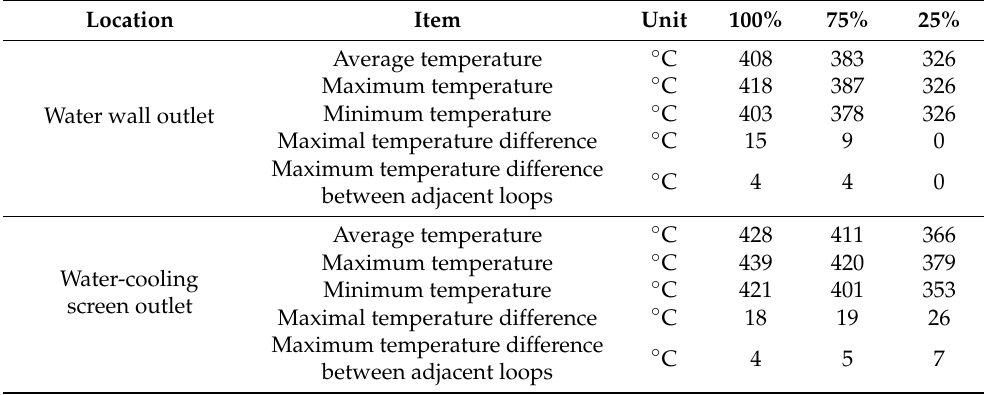
Table 3. Outlet tube temperature deviation of the water wall system under different boiler load.